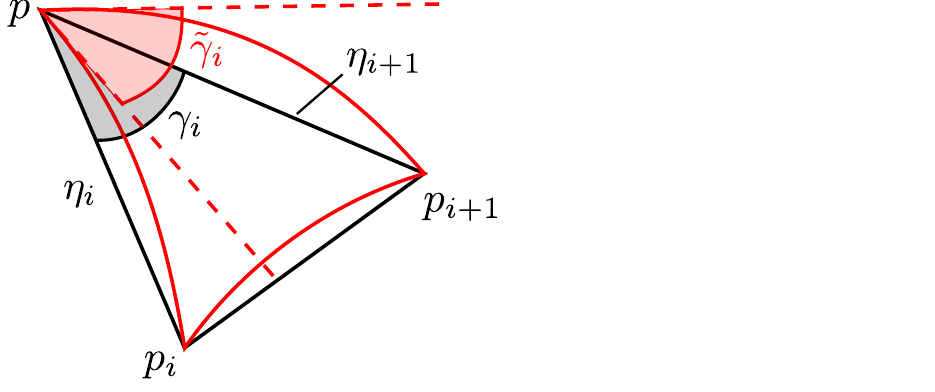
Figure 2. Description of the Euclidean and geodesic triangles { pp i p i + 1 } . The points p i and p i + 1 belong to the one-ring neighbor points of p . Their Euclidean distance to p is given by η i and η i + 1